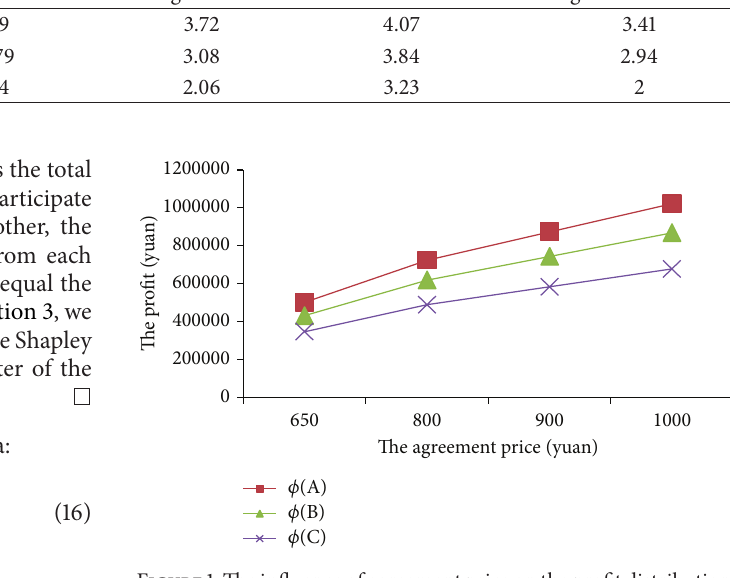
Figure1:Theinfluenceofagreementpriceontheprofitdistribution.